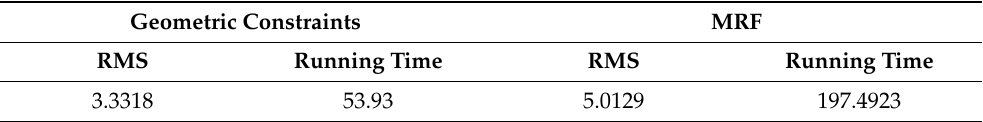
Table 1. The running times and the square roots of the mean square error of the two methods were compared and analyzed at the paper data